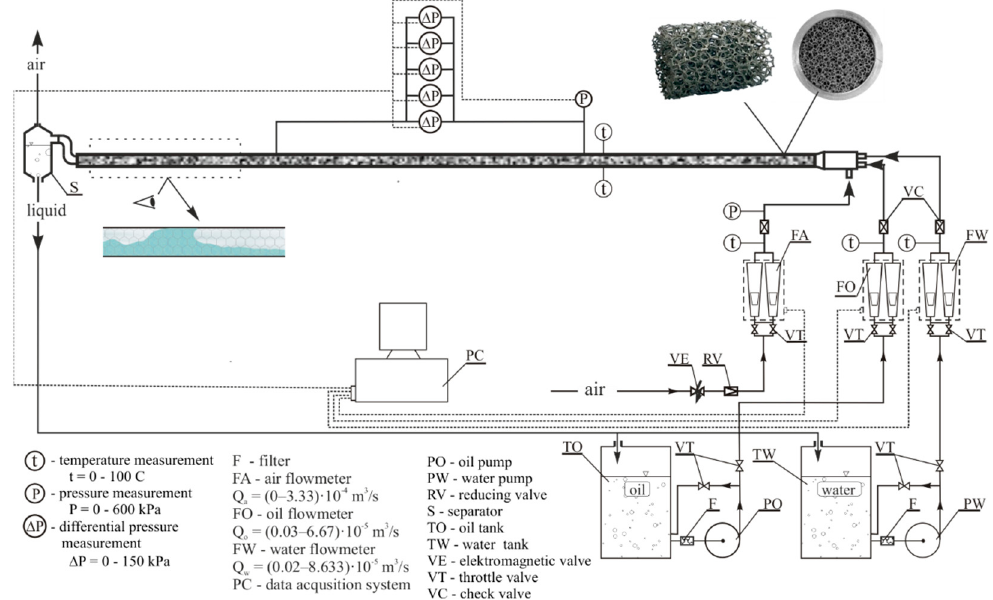
Figure 2. Diagram of the experimental stand used to single-phase and two-phase flow tests.